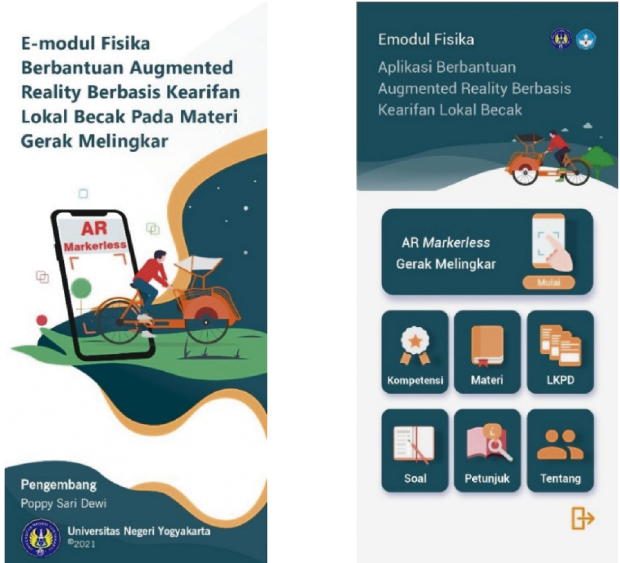
Figure 7. Cover and Menu of E-module